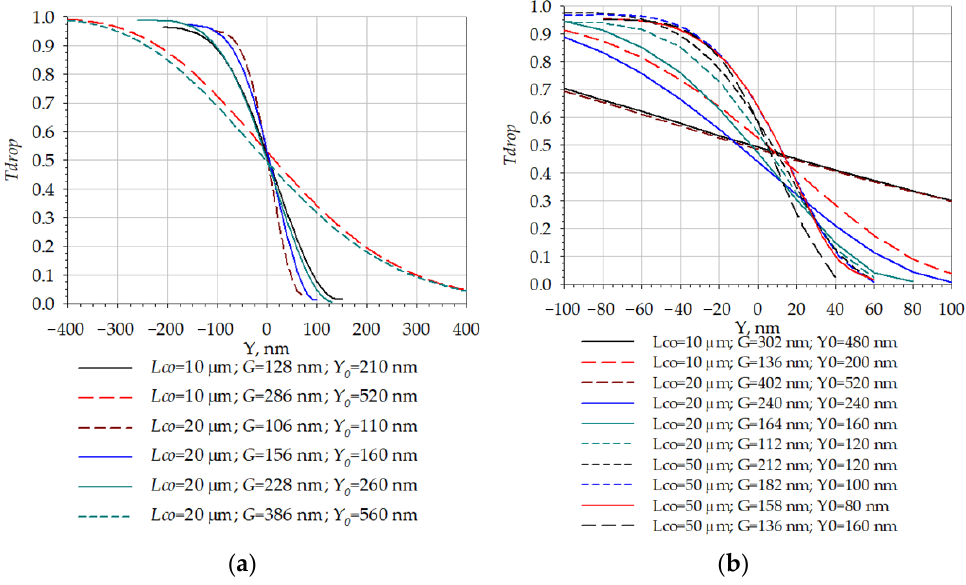
Figure 20. Dependencies of the optical transmission coefficient on the inertial mass linear displace- ment along axis Y for the OMT with different-plane waveguides (Scheme 7). ( a ) Waveguides with dimensions of 300 × 1000 nm; ( b ) Waveguides with dimensions of 300 × 750 nm. Table 2. Summarized data for the functional schemes of the accelerometer.